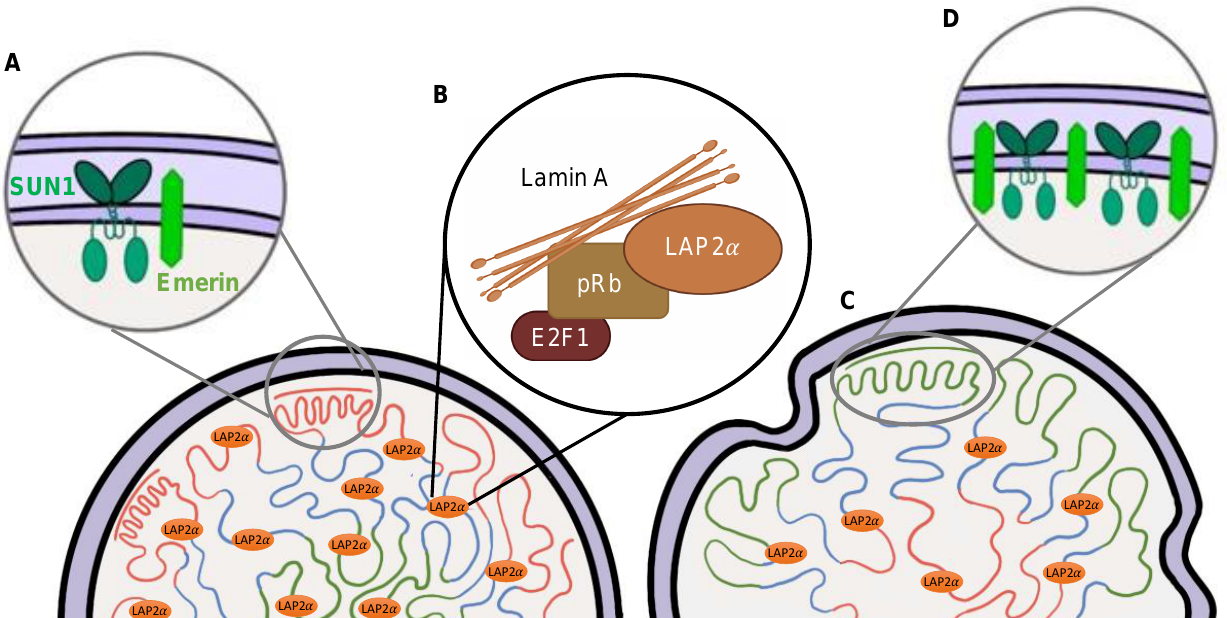
Figure 3. Nuclear structure, nuclear membrane protein, and chromatin alterations with the expression of progerin. ( A ): Emerin and SUN1 are inner nuclear membrane proteins that interact with lamin A. ( B ): LAP2 α is a protein localized to the nucleoplasm also in association with lamin A. Furthermore, they both play an important role in regulating the phosphorylated retinoblastoma (Rb) protein (pRb) and E2F1 (a transcription factor). ( C ): After the expression of progerin, chromatin alterations are identified with the typical heterochromatin localizing inside the nucleoplasm. In addition, there are nuclear shape aberrations as well as decreased LAP2 α expression. ( D ): Increased SUN1 and emerin expression correlated with progerin presence at the nuclear